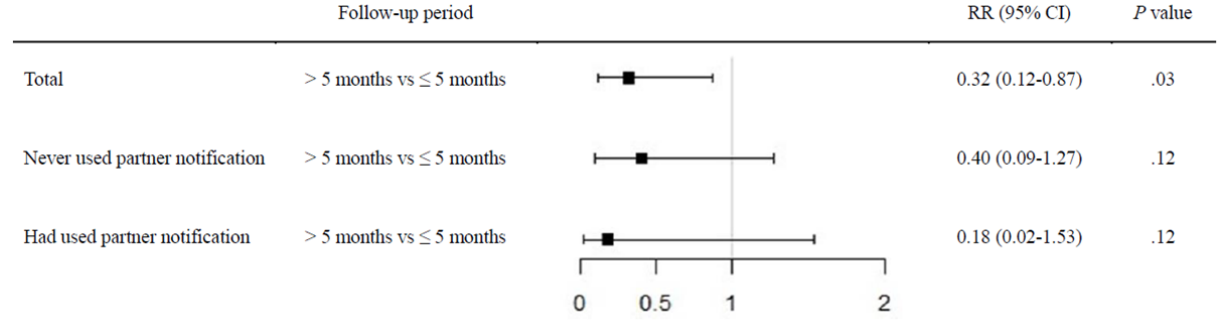
Figure 7. HIV infection risk between different periods of follow-up. RR: risk